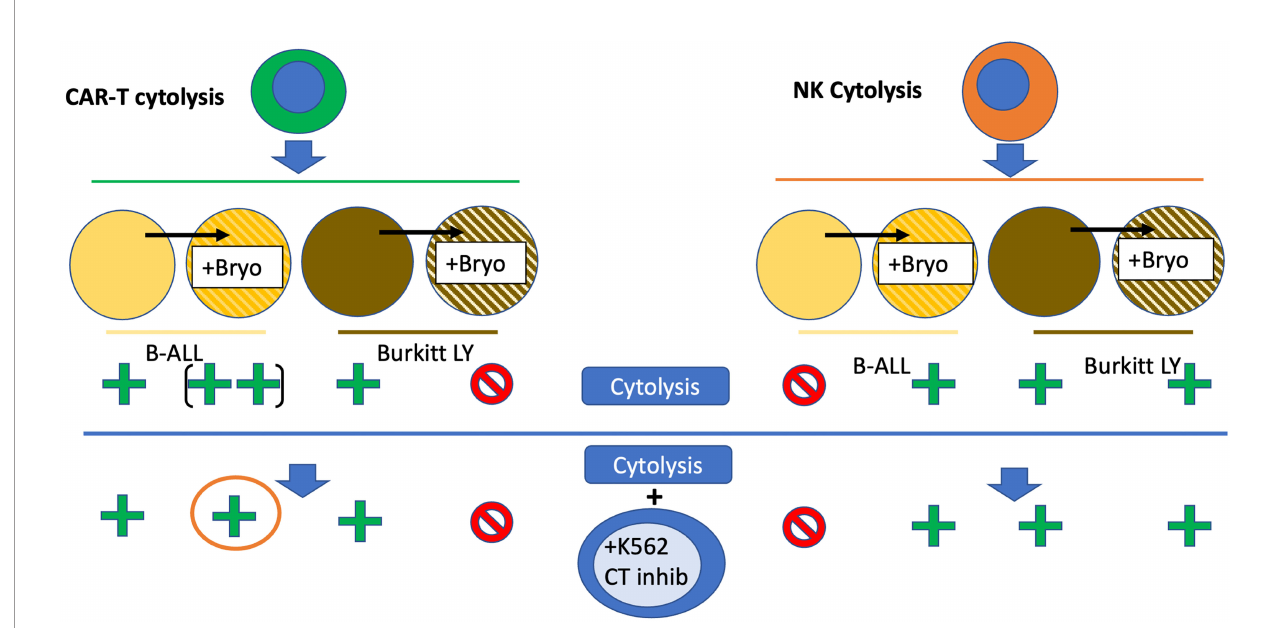
FIGURE 13 | Bryostatin modulation of CAR-T and NK92-based leukemia cell line cytolysis. Bryostatin treatment of pre-B ALL (yellow to striped yellow) and Burkitt (brown to striped brown) cell lines alters sensitivity to effector cell cytolysis. CAR-T cytolysis (left half, green cell) is ampli fi ed by bryostatin treatment (+ to ++) for B- ALL, and blocked for Burkitt ’ s (+ to -). Progressing to the lower portion of the fi gure illustrates the effect of K562 cell mediated cold-target inhibition (+K562 CT inhib). CAR-T mediated killing of Burkitt ’ s is unaffected, while some of the bryostatin facilitated killing of B-ALL is lost (orange circle). For NK cytolysis (orange cell, right half), the induction of a new set of innate immune ligands that now allow for killing of B-ALL is illustrated (- to +). Burkitt ’ s remains unaffected, and universally sensitive. The induced ligands on B-ALL are unaffected by cold-target inhibition and remain sensitive to NK